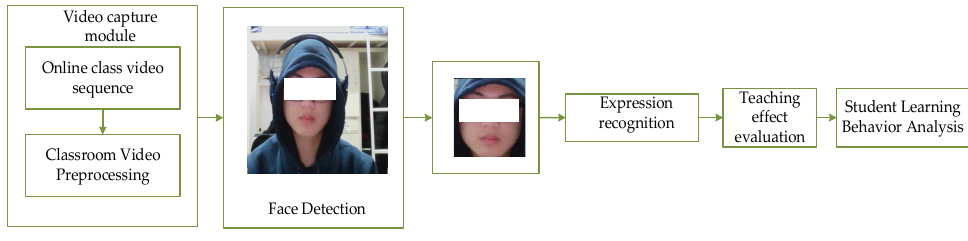
Figure 1. System composition.